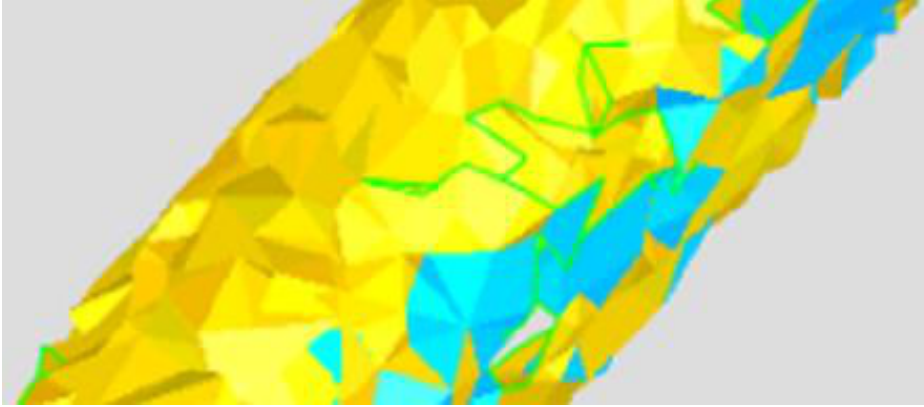
Figure 3. Wellbore surface constructed by Delaunay irregular triangulation mesh.